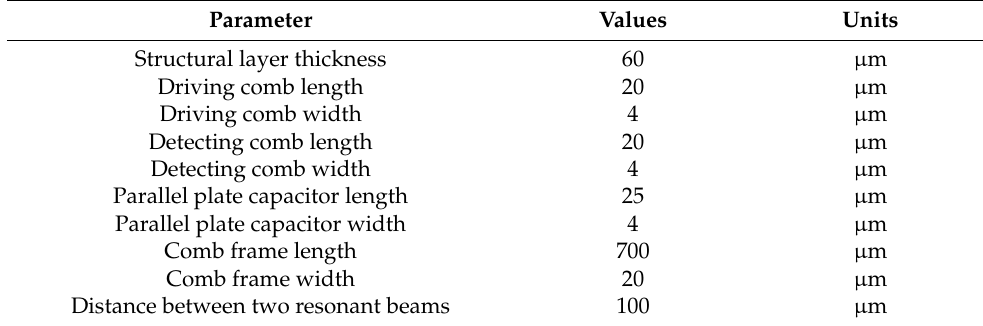
Distance between two resonant